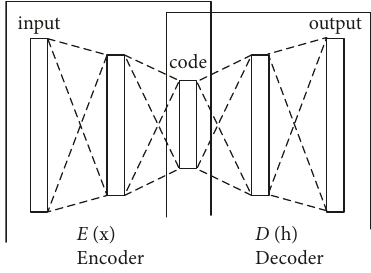
Figure 2: The Autoencoder